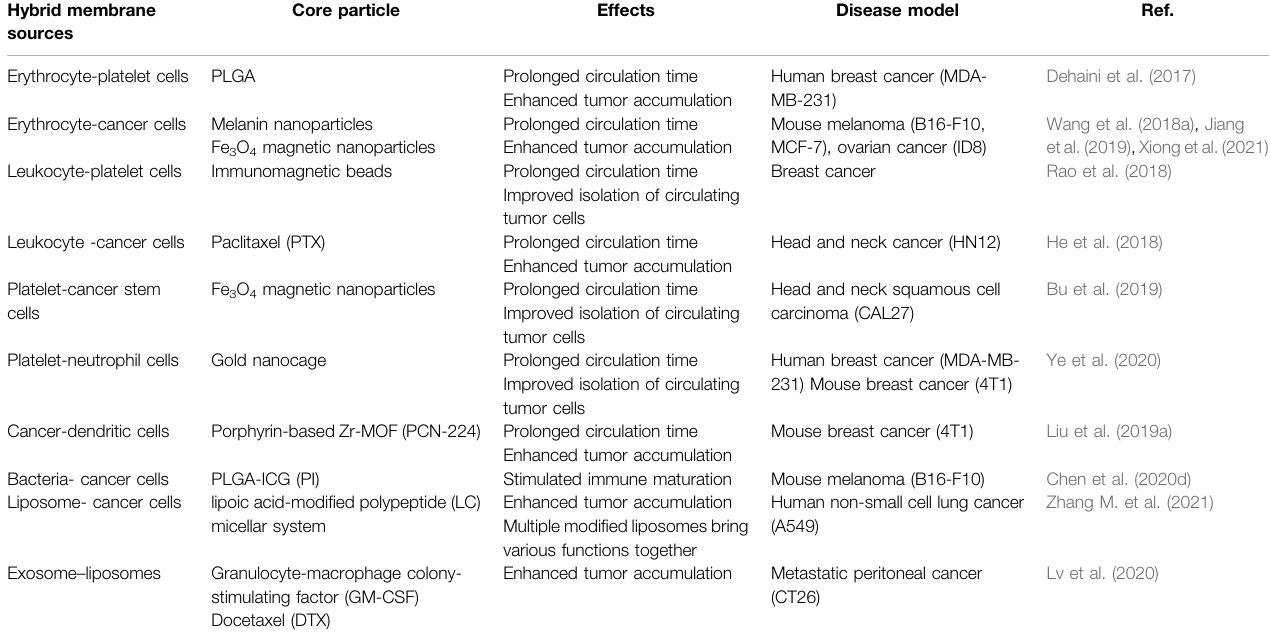
TABLE 2 | Summary of different types of hybridized membrane-functionalized nanoparticles. Hybrid membrane sources